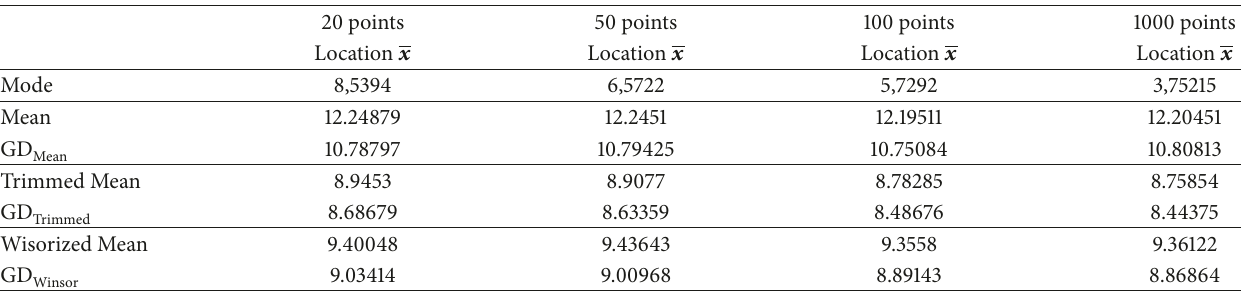
Table 3: In this table the values of location for a log-normal distribution of parameters 𝑥 = 2 and 𝑠 = 1 and 30 % of Gaussian noise are reported. The level of noise is expressed as percentage of the mean of the distributions. In the columns we have the location values when the distributions are composed with 20, 50, 100, and 1000 points.